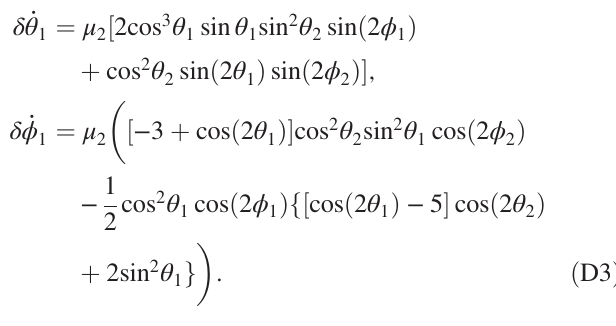
FIG. 15. The deformation μ 2 ¼ 0 . 24 and μ destroys the eigenstates with low bipartite entanglement entropy in the pure PXP model. The data are obtained for the L ¼ 28 chain with periodic boundary conditions in the zero-momentum inversion-symmetric